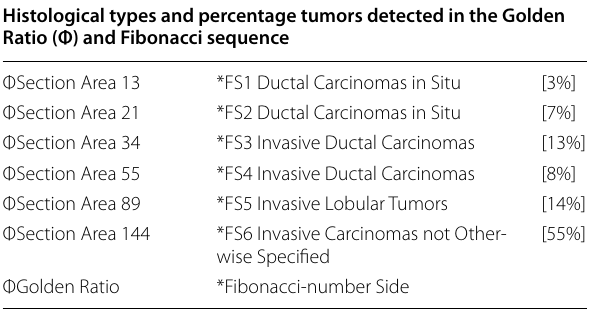
Table 1 Predictive algorithm breast